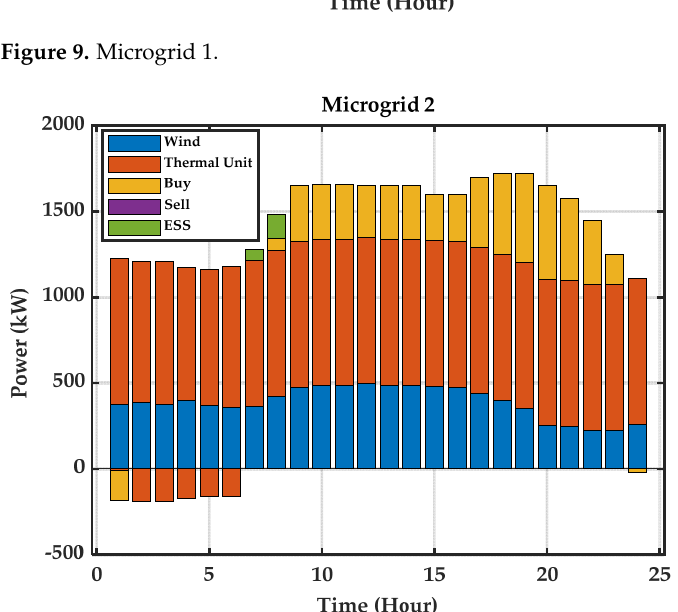
Figure 10. Microgrid 2 response.